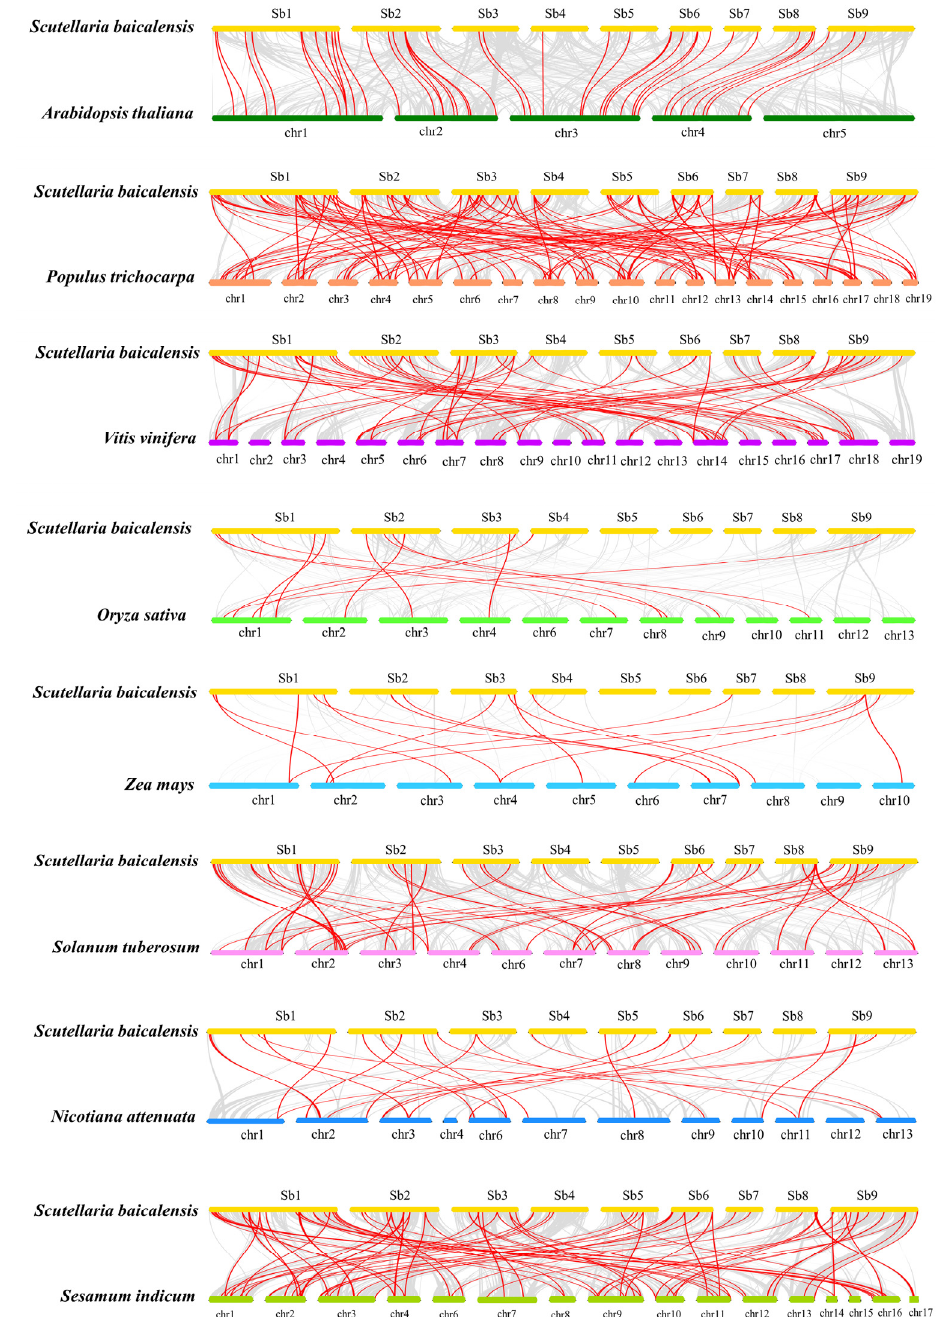
Figure 5. Synteny analysis of S. baicalensis R2R3-MYB genes in comparison with eight other repre- sentative plant species ( A. thaliana , P. trichocarpa , V.vinifera , S. tuberosum , N. attenuata , S. indicum O. sativa , and Z. mays ). Red lines highlight the syntenic R2R3-MYB gene pairs between S. baicalensis and the other plants, while gray lines illustrate all collinear blocks.